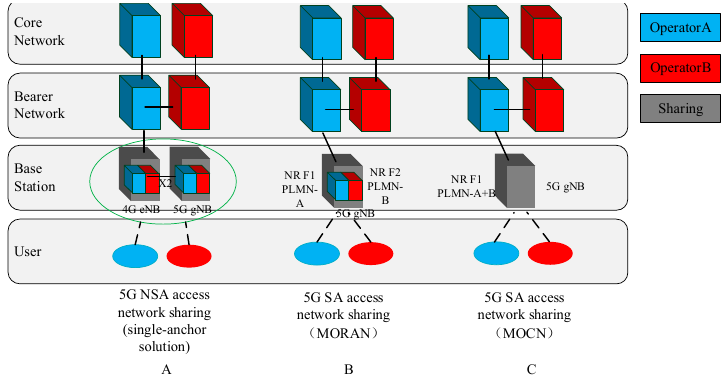
Figure 1. Access network sharing